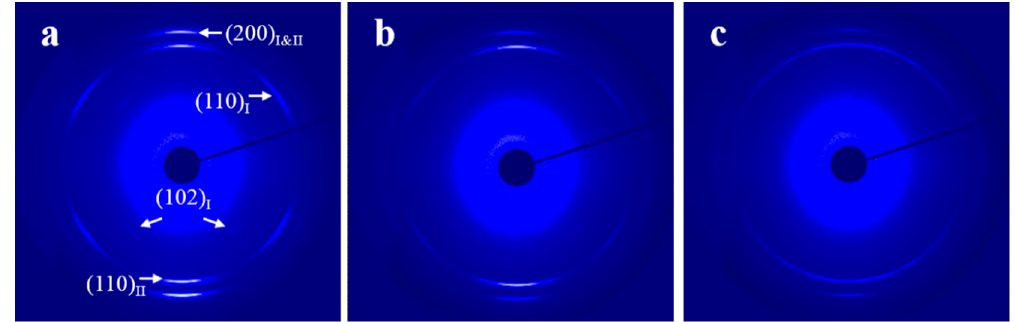
Figure 6. WAXD patterns of L-PCL/PVC blend films crystallized at 40 °C under various draw ratios for different times. ( a ) λ = 3, t c =4 h; ( b ) λ = 4, t c = 2.5 h; and ( c ) λ = 5, t c = 2 h. The drawing direction is vertical.